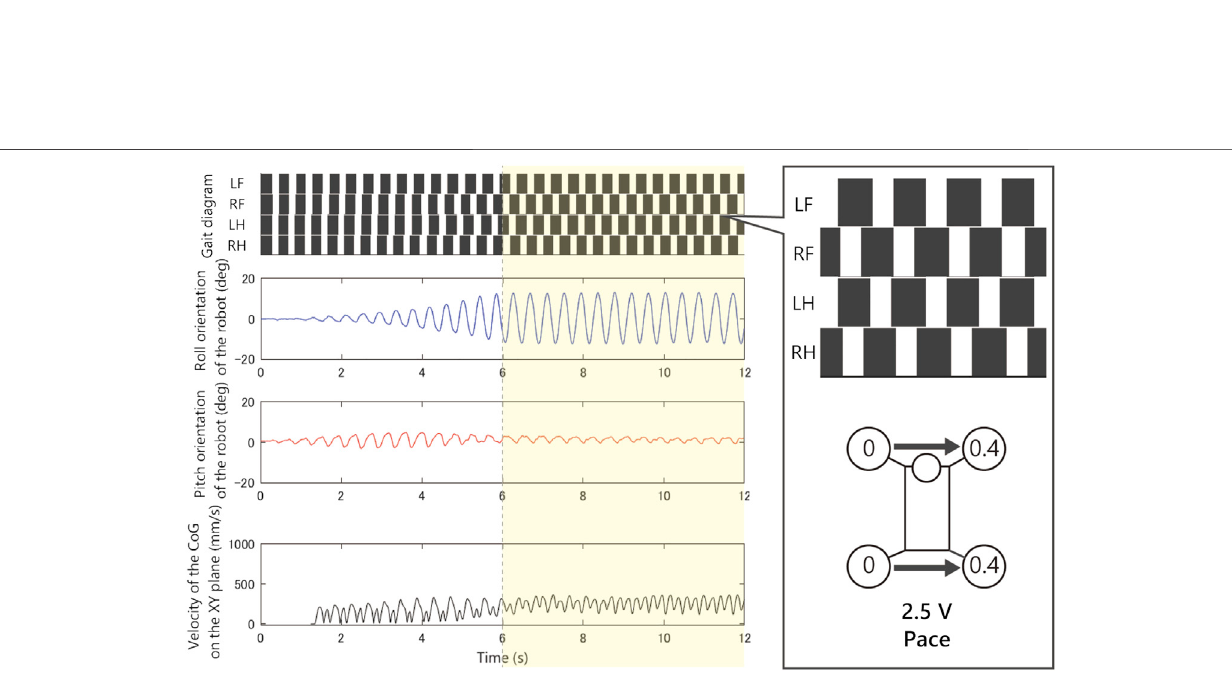
Frontiers in Robotics and AI |